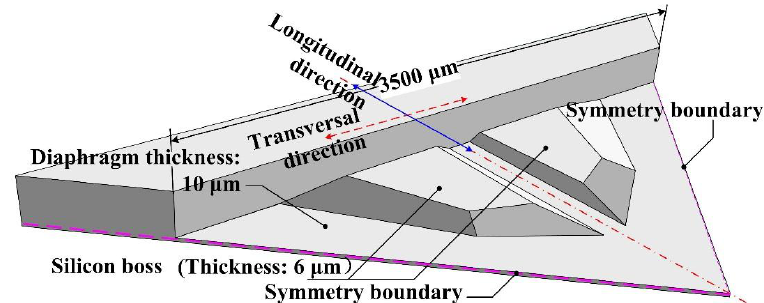
Figure 6. Stiffness distribution pattern for condition IV discussion.